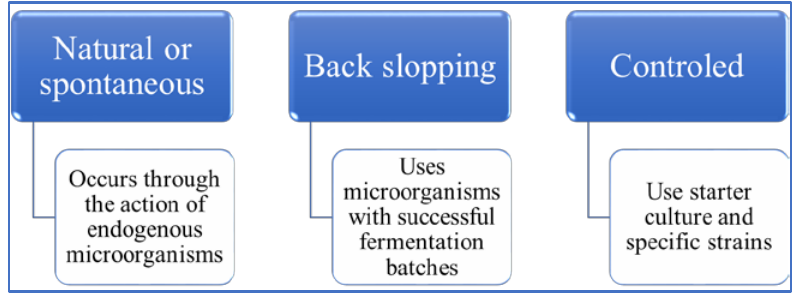
Figure 4. Conventional techniques for fermentation processes.